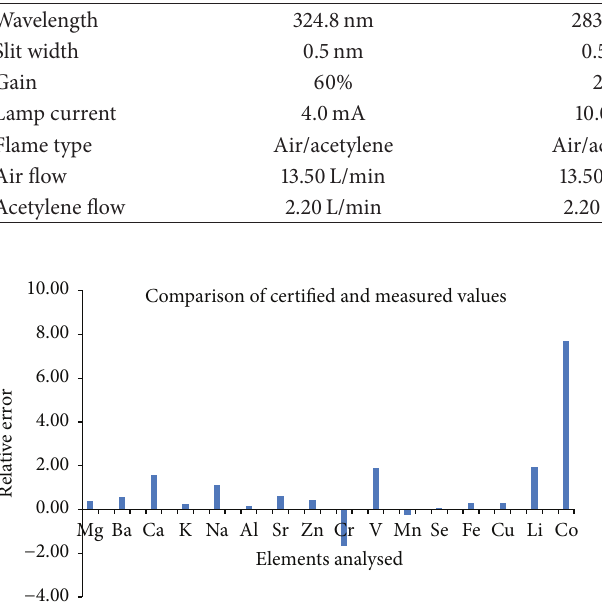
Figure 1: The relative error based on comparison of the certified and measured